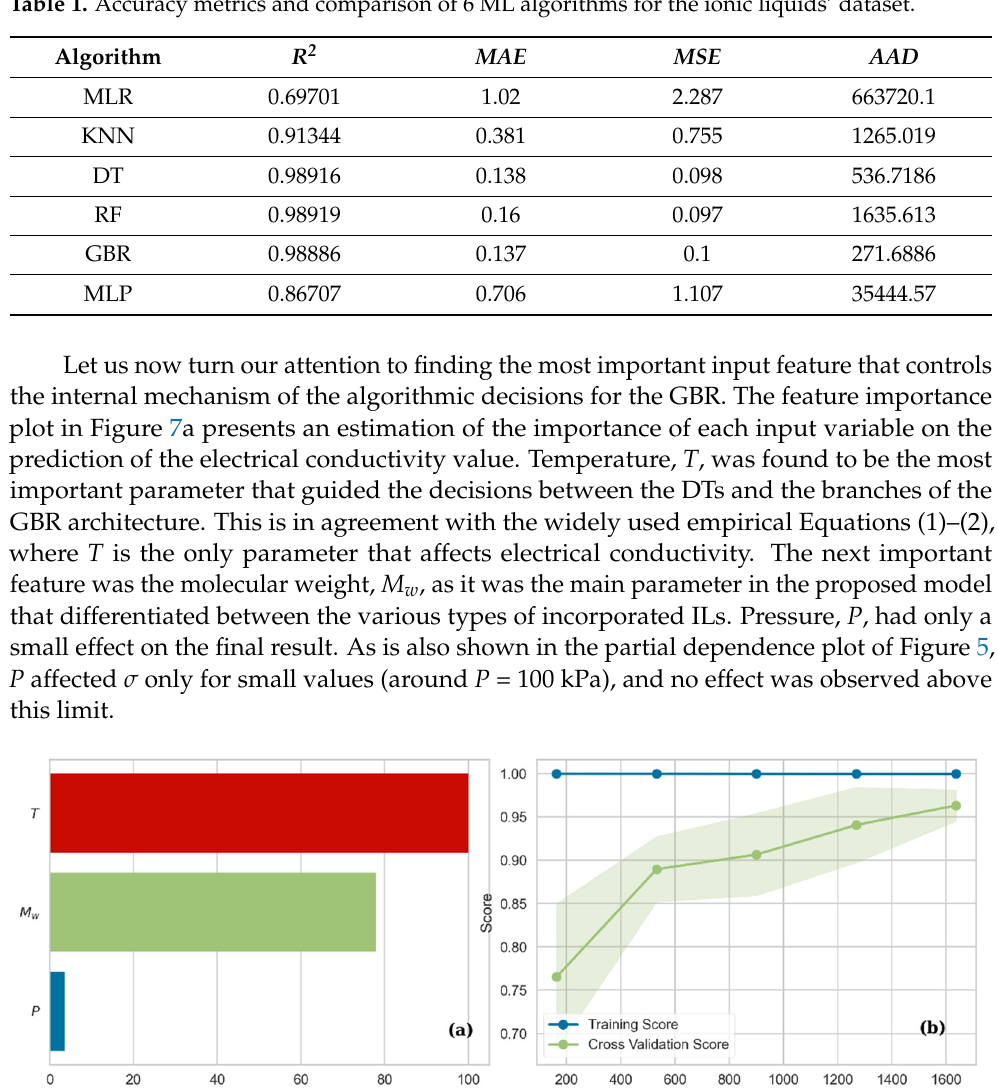
Table 2. The three SR-extracted equations for electrical conductivity and their respective accuracy metrics. Comp . is the equation complexity. Equation Comp.